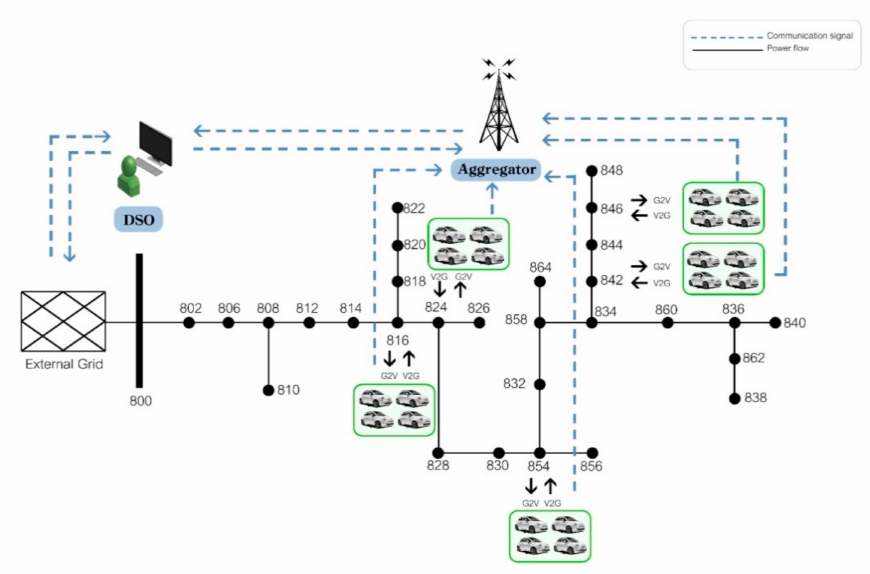
Figure 1. Application of the proposed method for customer and grid benefits.